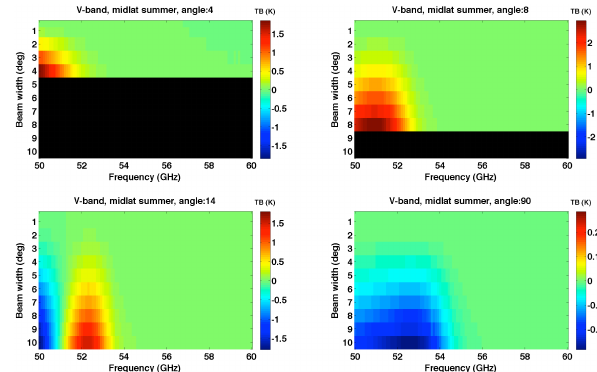
Fig. 13. Explanation of over and under estimations that cause the Figure 13. Explanation of over and under estimations that cause the beam width errors, which 5 beam width errors, which are linked to the curvature of the TB are linked to the curvature of the TB vs angle curve in V-band for the mid-latitude summer 6 vs. angle curve in V-band for the mid-latitude summer sounding. The vertical dotted lines represent the 10 ◦ beam width (centre line sounding. The vertical dotted lines represent the 10° beam width (center line is center angle). 7 is centre angle). The short horizontal dashed lines are used to lo- The short horizontal dashed lines are used to locate the intersection of the extremities of the 8 cate the intersection of the extremities of the beam width and the beam width and the dashed dot line locates the center angle on the TB curve. These additional 9 dashed dot line locates the centre angle on the TB curve. These ad- lines help to visually see that the over-estimation and under-estimation errors are linked to the 10 ditional lines help to visually see that the over-estimation and under- curvature of the TB curve. 11 estimation errors are linked to the curvature of the TB curve.